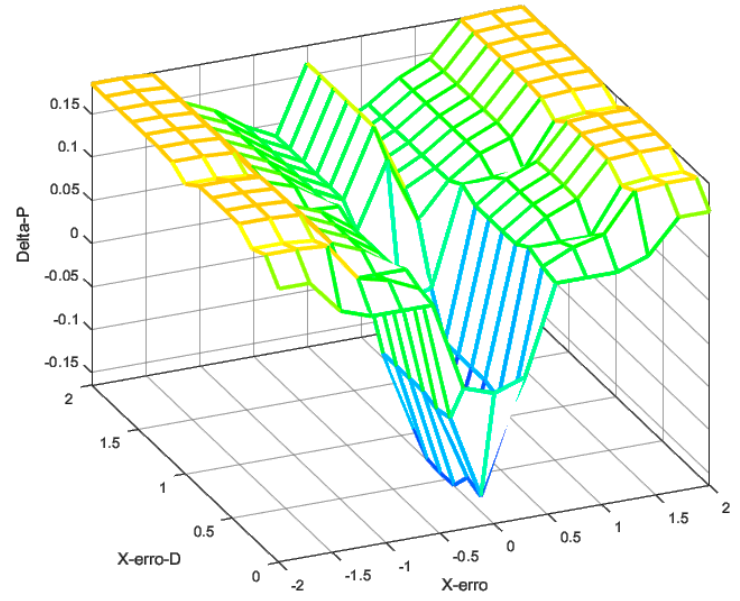
Figure 8. Fuzzy surface for proportional